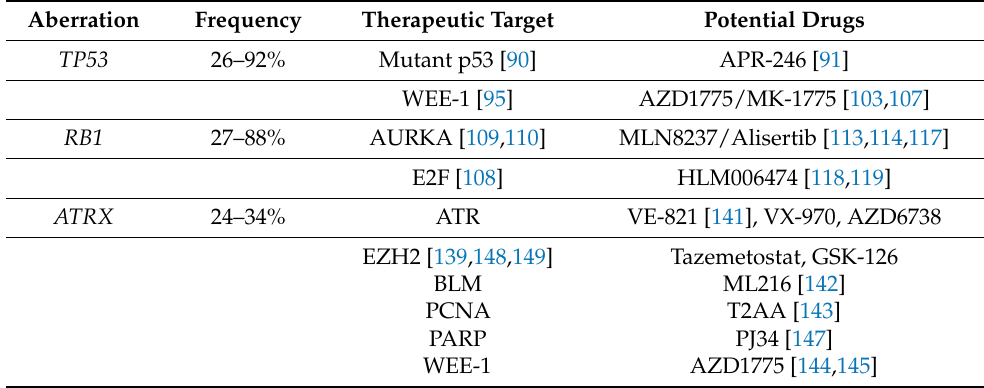
Figure 1. Summary of the common genetic aberrations in uLMS and their potential therapeutic targets. Table 3. Summary of the potential therapeutic targets that arise due to genetic aberrations frequently occurring in uLMS.